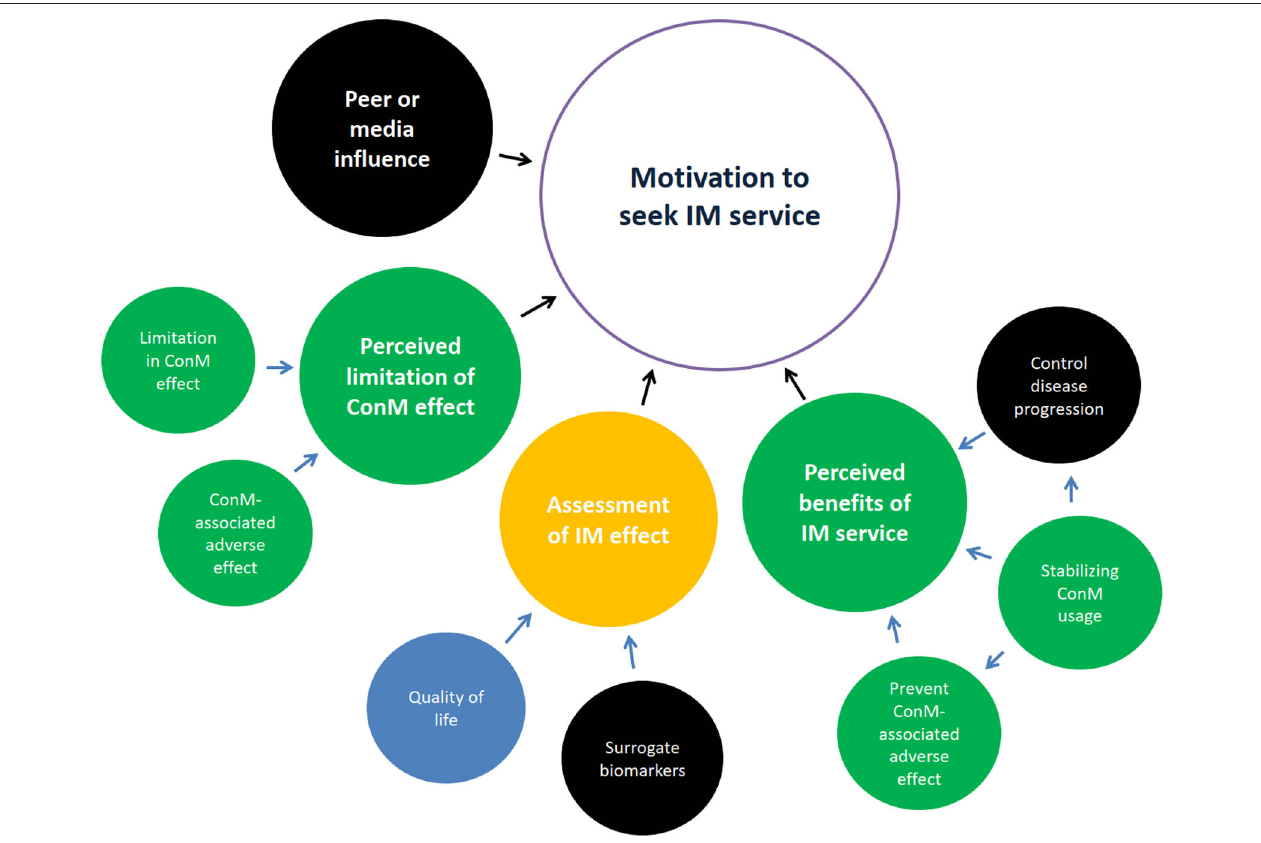
FIGURE 1 | Motivation to seek integrative medicine (IM) service. Themes generally agreed upon by patients in yellow, by Chinese medicine (CM) physicians in blue, by conventional medicine (ConM) physicians in red, by both patient and CM physicians in green, by both patient and ConM clinician in orange, by all parties in black. Control of disease progression was the common perceived benefit of IM. Stabilizing ConM usage was emphasized by patients and acknowledged by CM physicians. Surrogate biomarkers were mutually accepted among patients and physicians. Importance on quality of life divided between patients and CM